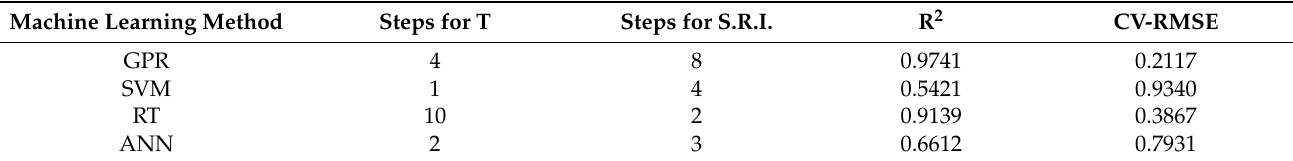
Table 1. Optimal step number and accuracy index with grid searching using 4 machine learning methods. Machine Learning